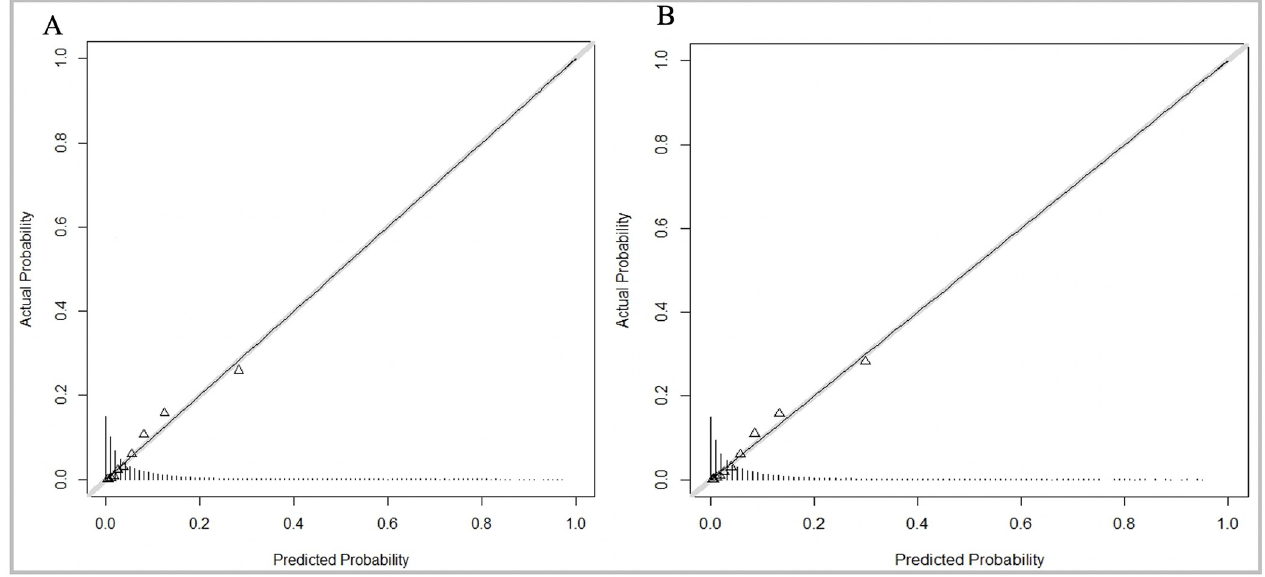
Fig 5. Calibration plots for the equation model in derivation and validation cohorts. The visual agreement between the MetS predictions (Predicted probability) and observations (Actual probability) for the equation model in the derivation and validation cohorts. A. Derivation cohort B. Validation cohort.